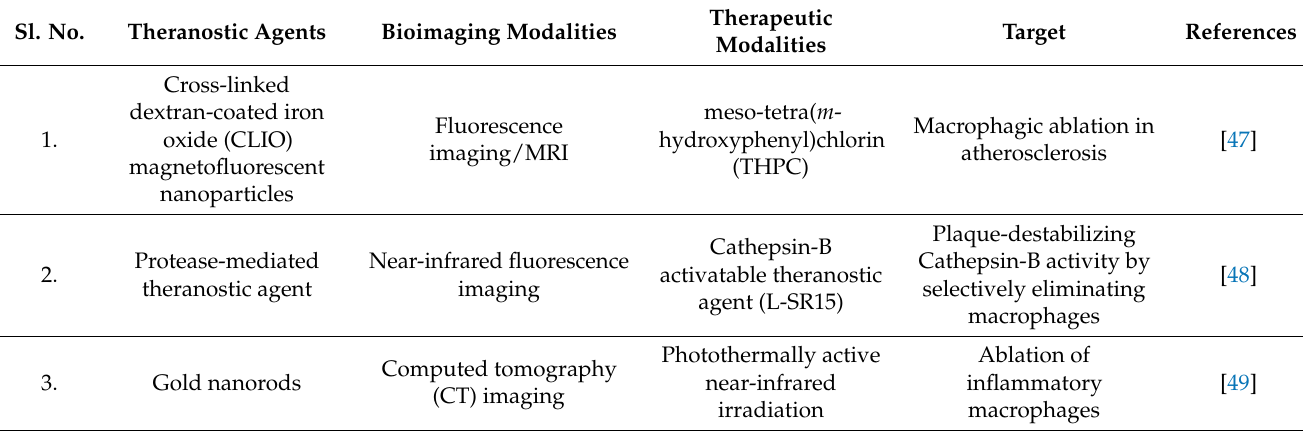
Table 1. List of notable theranostic nanoparticles designed and developed for the diagnosis and therapy of atherosclerosis, an important factor of cardiovascular diseases (CVDs) since the 2010s. Sl.